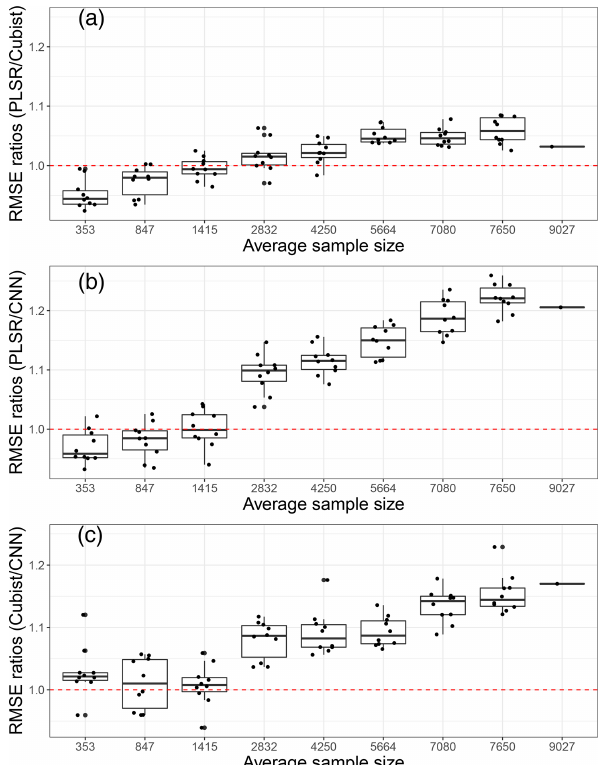
Figure 7. Model performances in terms of root mean square error (RMSE) ratios of (a) partial least squares regression (PLSR) over Cubist model, (b) PLSR over convolutional neural network (CNN) model and (c) Cubist over CNN as an average of five soil properties, based on various sample size using 10 simulations. The red dotted line represents a 1:1 RMSE